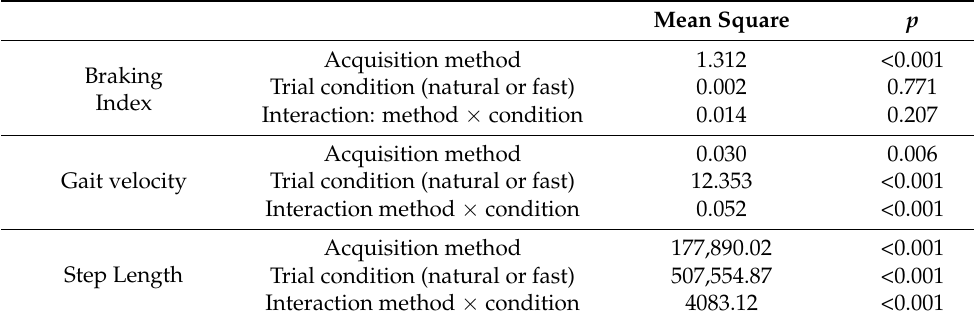
Table 2. Results of the two-way (trial condition × acquisition method) repeated-measure ANOVA on braking index, gait velocity, and step length during gait